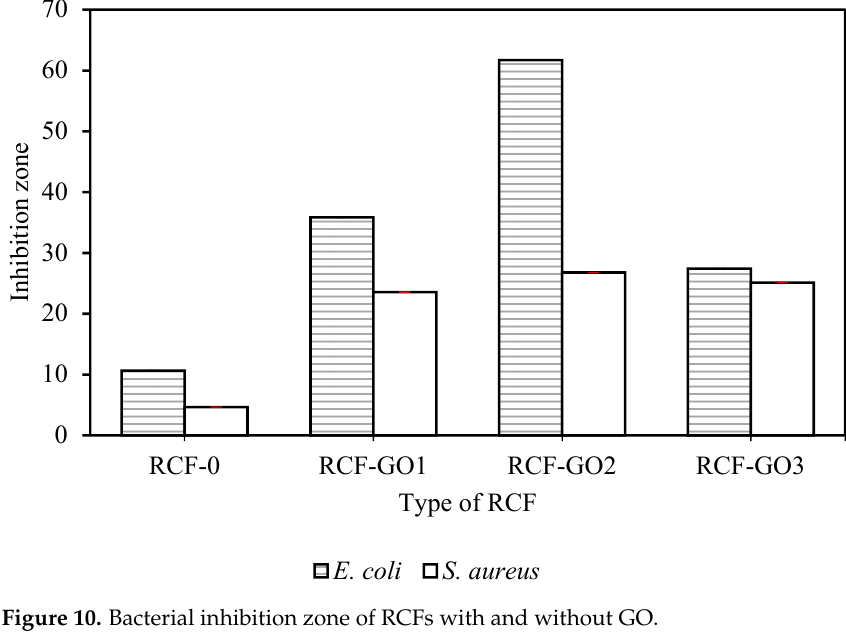
Figure 10. Bacterial inhibition zone of RCFs with and without GO.